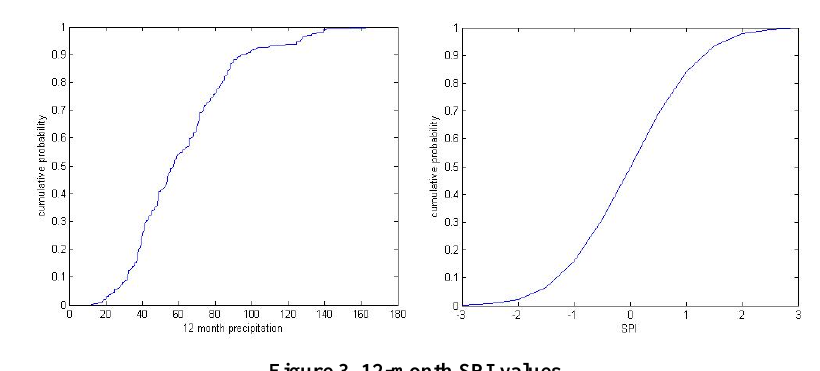
Figure 3. 12-month SPI values.